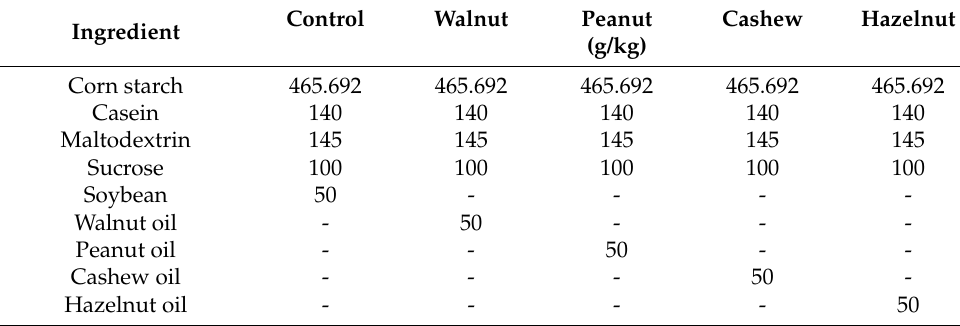
Table 2. Formulation of the AIN-93M * diet for maintenance of adult rats.